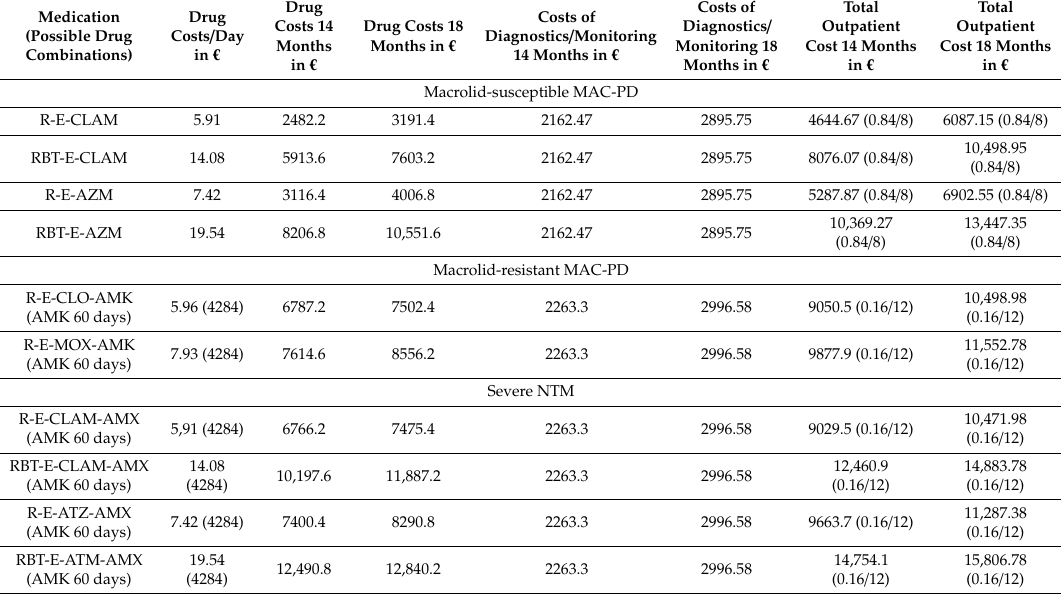
Total costs of diagnosing, monitoring, and treating pulmonary MAC disease in German